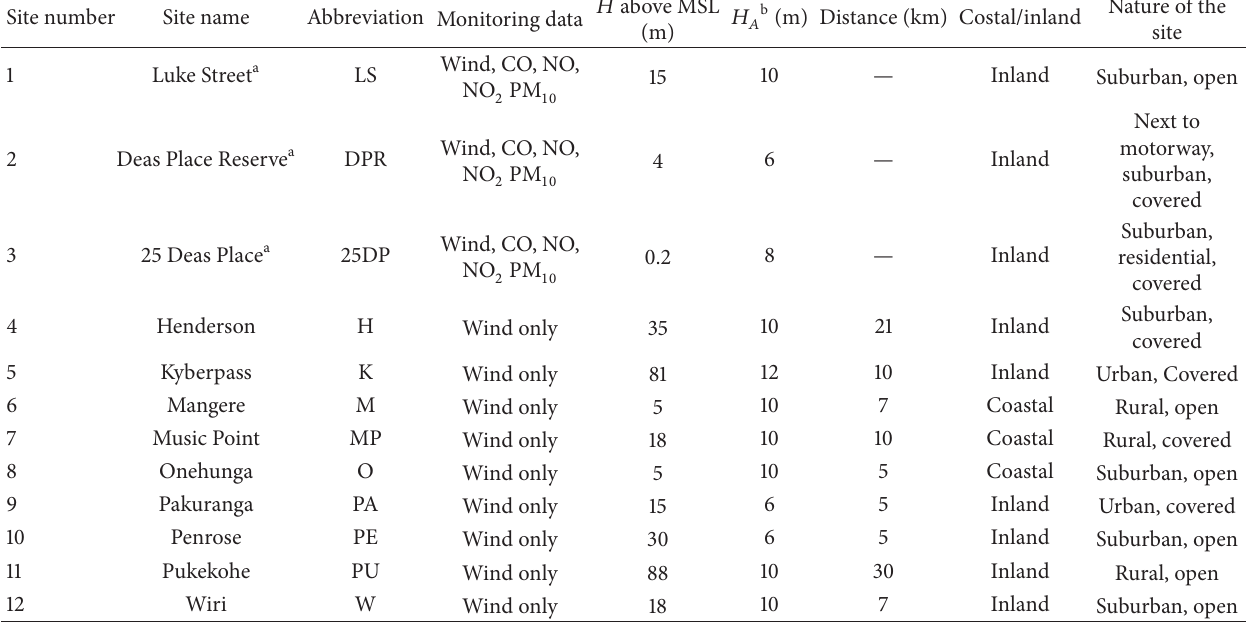
Table 1: Air pollution and meteorological